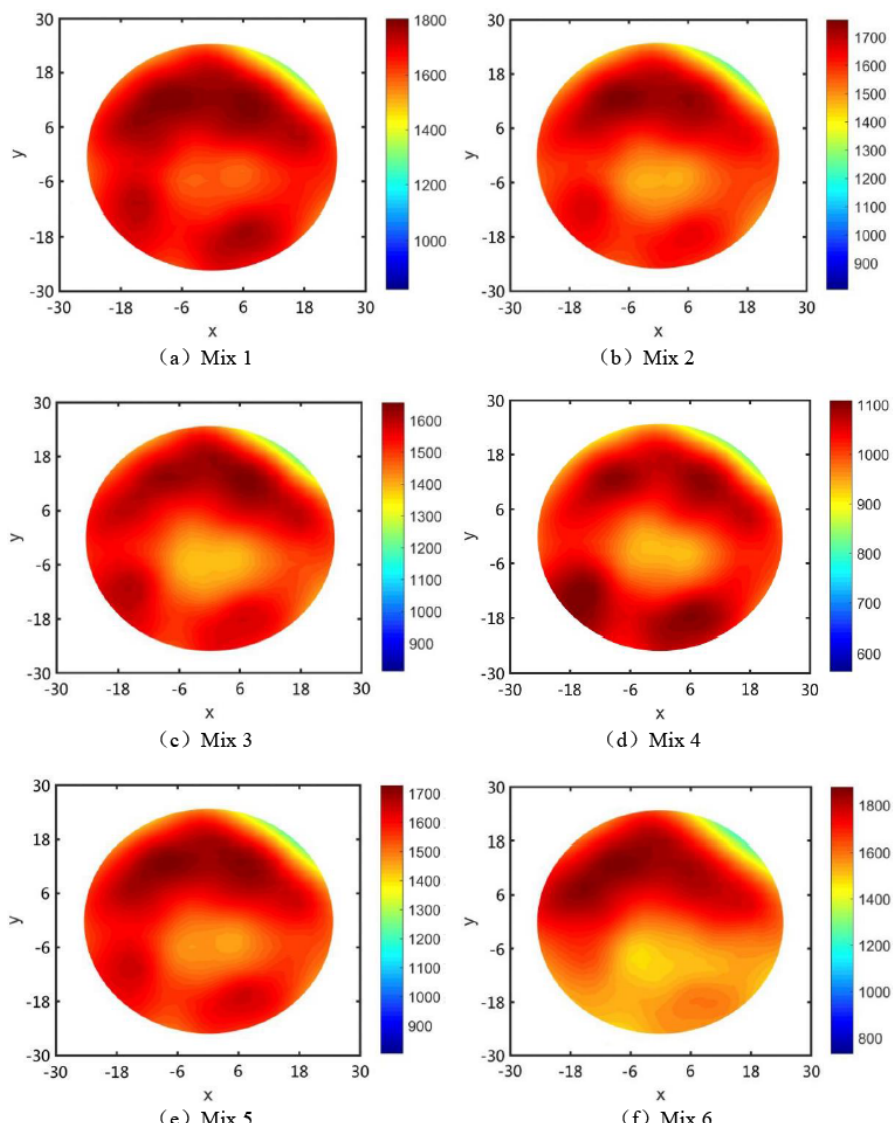
Figure 8. A 3D distribution of MRR of different FAPs under different mixes.